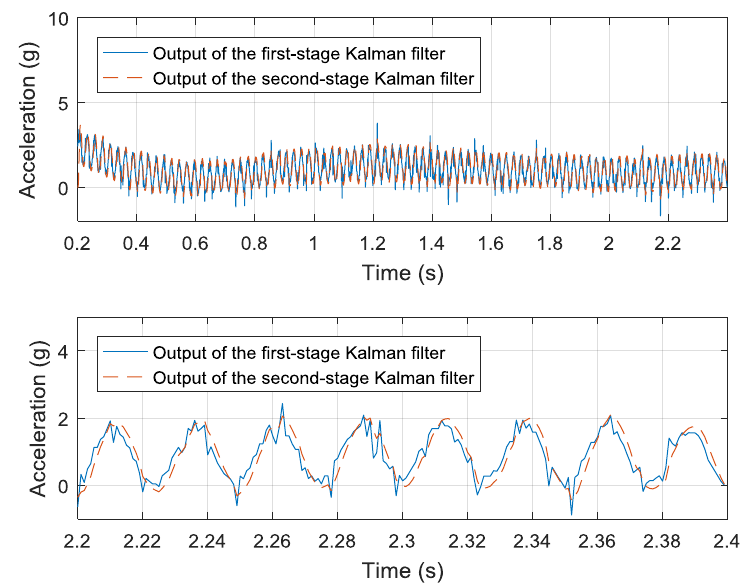
Figure 12. The results of two Kalman filters on a time scale of 2.2 s and 0.2 s.